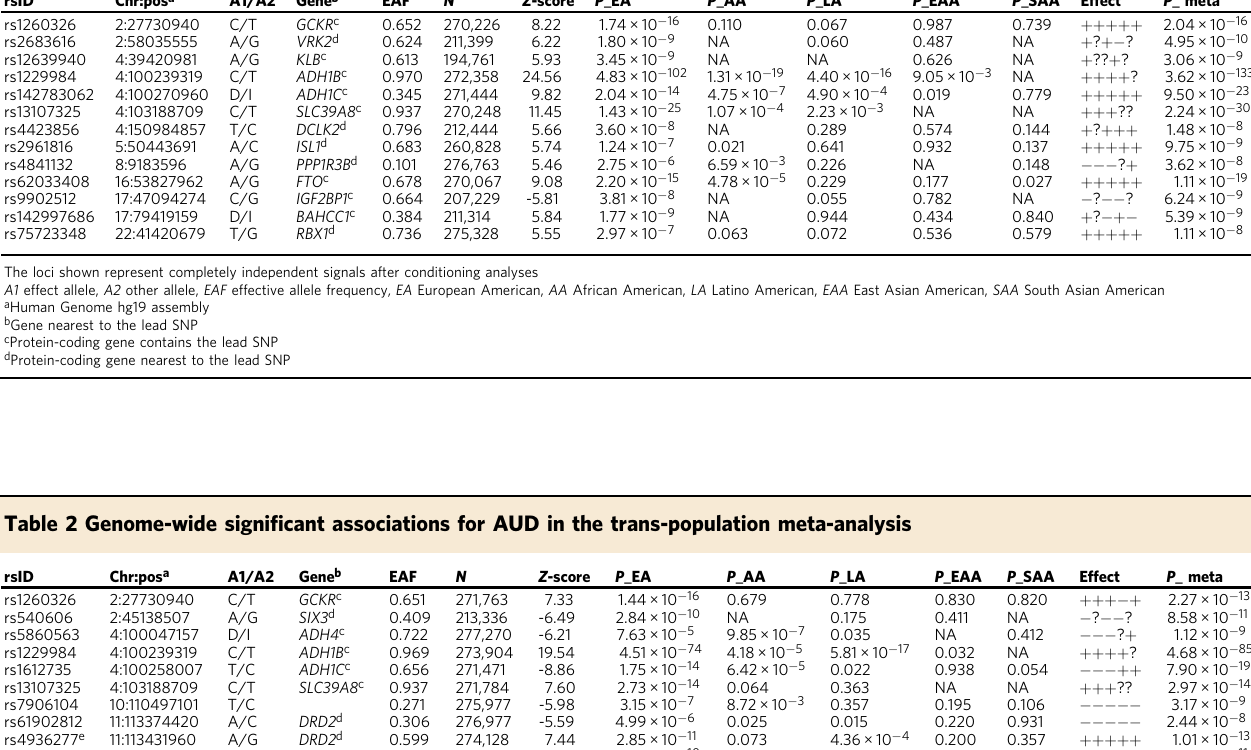
Table 1 Genome-wide signi fi cant associations for AUDIT-C in the trans-population meta-analysis rsID Chr:pos a